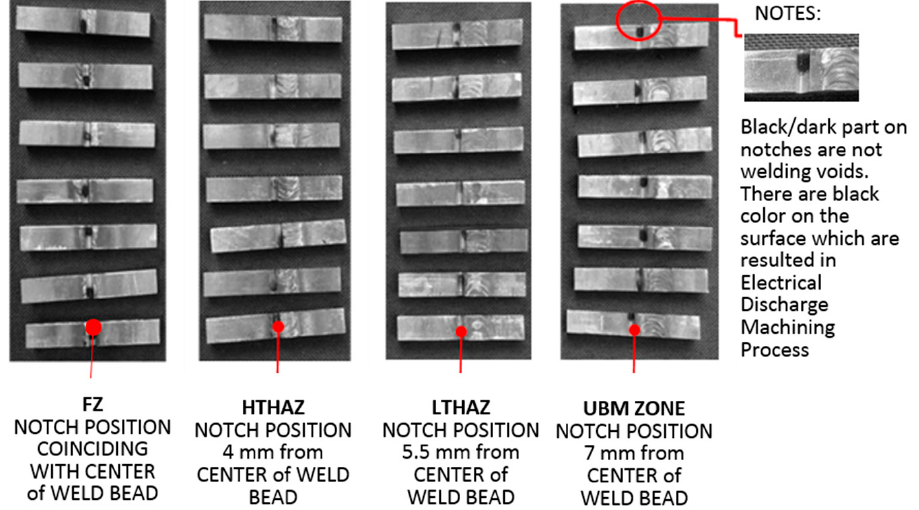
Figure 3. Notch position in an AISI 304 welding Charpy Impact specimen.